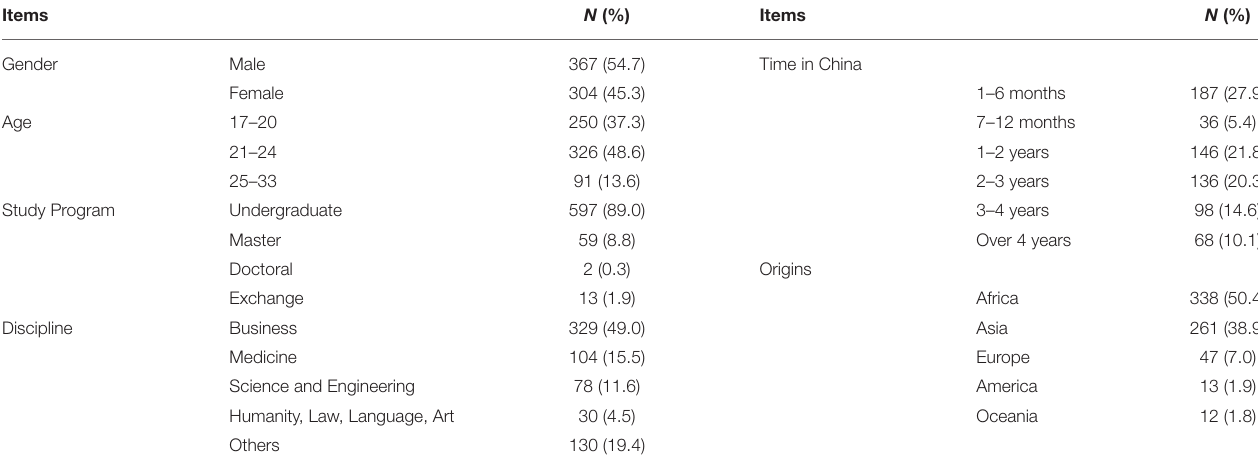
TABLE 1 | Demographic information of the survey ( N =